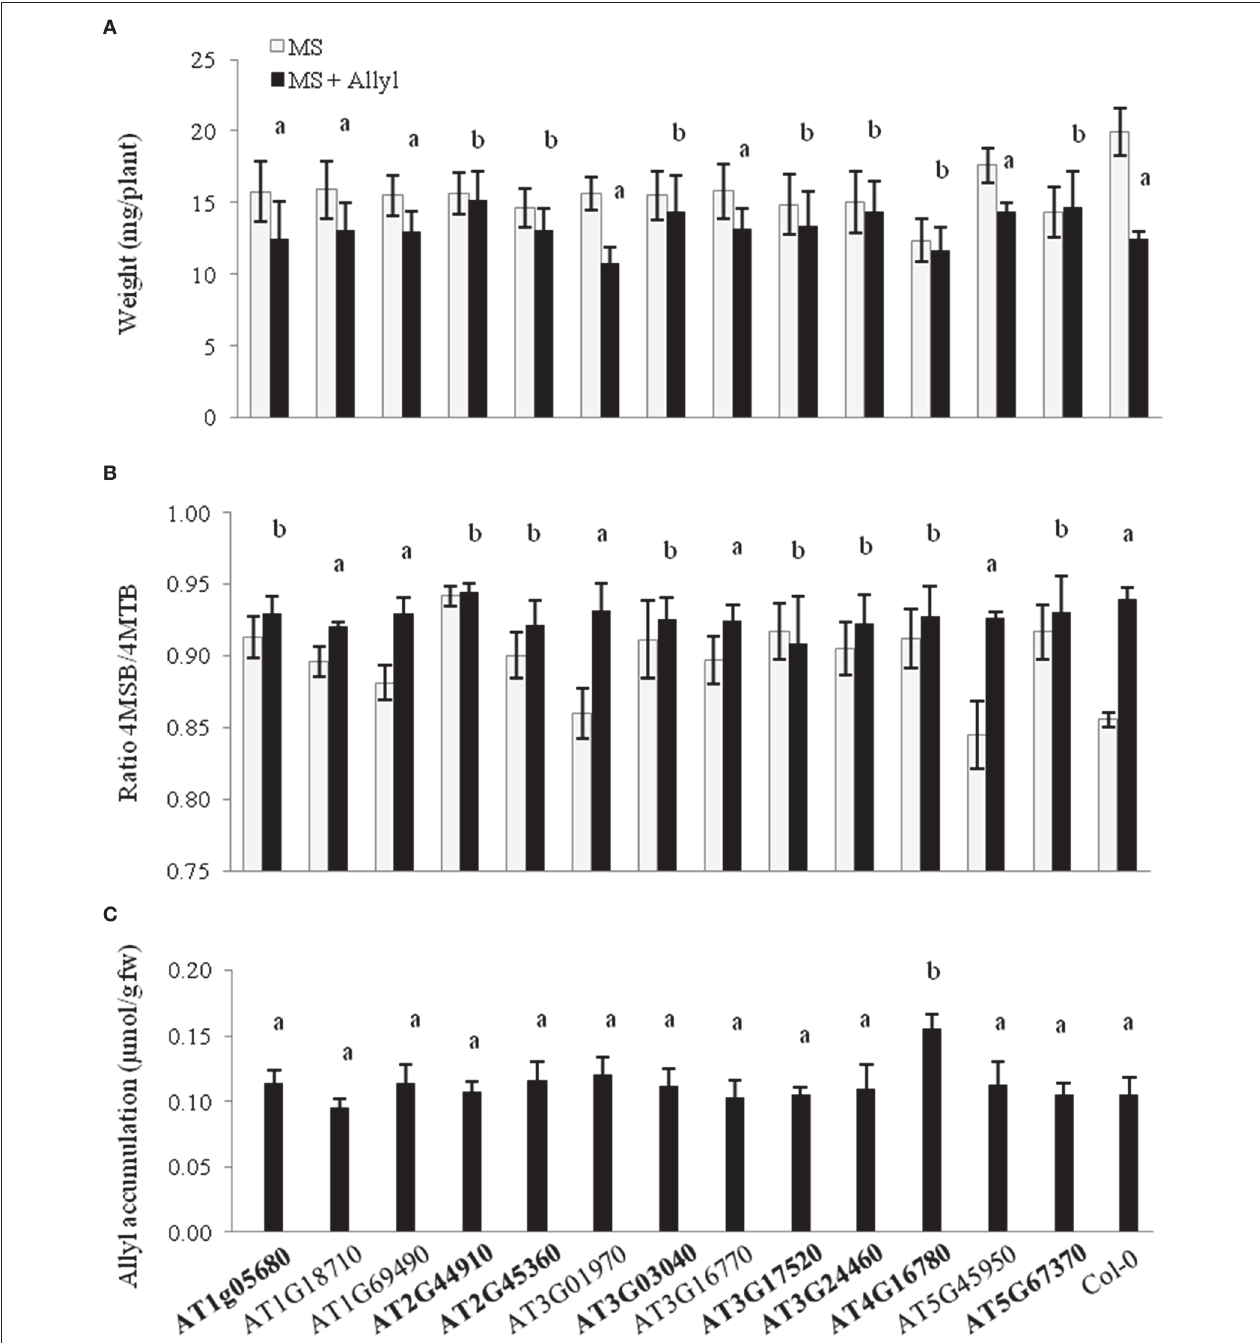
FIGURE 6 | Plant biomass responses and GSL content variation among T-DNA insertion lines of 13 candidate genes treated with allyl GSL. (A) Quantification of 15-day-old fw (mg/plant) seedlings from T-DNA insertion lines of 13 candidate genes and wild-type (Col-0) fed with 50 µ M of allyl glucosinolate. (B) Ratio of 4-methylsulfinylbutyl (4MSB)/4-methylthiobutyl (4MTB) calculated as 4MSB/(4MSB + 4MTB). (C) Average allyl GSL accumulation of the evaluated genotypes. The bar chart represents the mean and the standard deviation. Each genotype within each treatment has a minimum of 40 independent measurements conducted across four experiments using a randomized block design. Means with the same letter show if the genotype’s response to the treatment was statistically similar to Col-0 (a) or different from Col-0 (b) at P ≤ 0.05 from the two-way ANOVA analysis (Table S5). Gene’s in bold have one or more phenotypes with a statistically different response to exogenous allyl treatment in comparison to Col-0. See Table 1 for T-DNA insertion lines details.